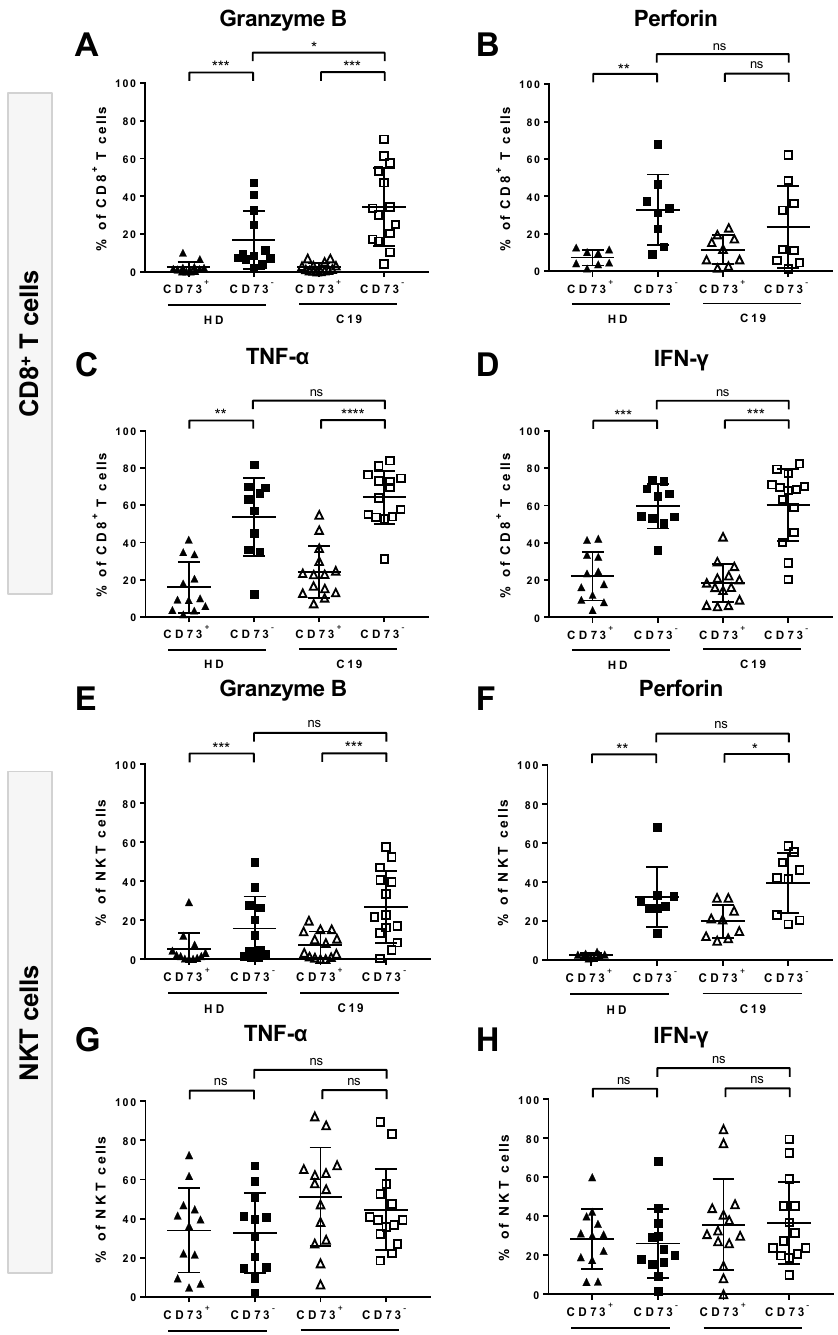
Figure 5. Cytokine / toxin secretion profile of CD73 - and CD73 + cells among CD8 + T and NKT cells. PBMCs from COVID-19 (C19) patients and healthy donors (HD) were analyzed ex vivo upon unspecific stimulation The secretion of granzyme B (GrB) ( A ), TNF- α ( C ), and IFN- γ ( D ) was significantly increased in CD73 - CD8 + T cells compared to their CD73 + counterparts in C19 patients and HD. Perforin secretion by CD8 + T cells was increased as well, although it only reached a statistical significance for HD ( B ). Regarding NKT cells, GrB ( E ) and perforin ( F ) secretion was significantly elevated in CD73 - NKT cells compared to their CD73 + counterparts in C19 and HD. TNF- α ( G ) and IFN- γ ( H ) secretion was similar in CD73 - and CD73 + NKT cells in both C19 and HD. Data are shown as mean ± SD.